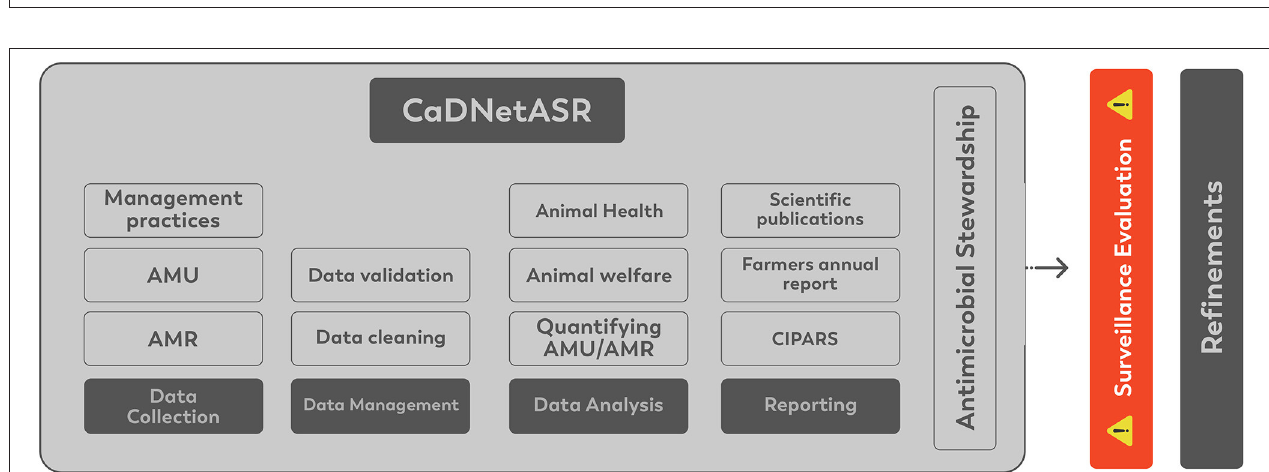
FIGURE 1 | CaDNetASR framework development and implementation.